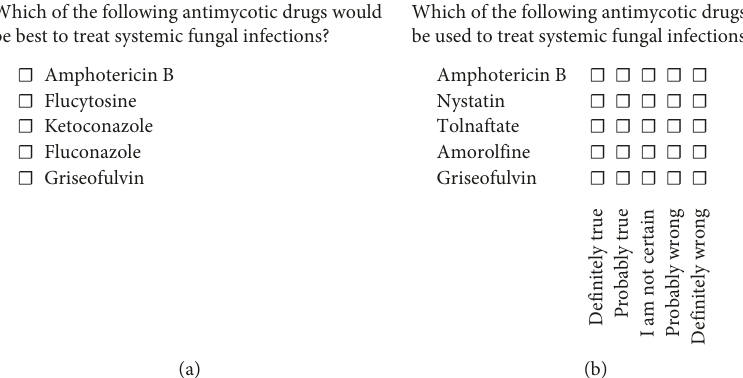
Figure 2: Examples of SC and R5 question types. Sample questions with their five alternatives and the corresponding key used in 2012. (a) Left panel: the question as it was used in prior exams in the SC format requiring to check the one and only true alternative and to leave false alternatives blank. (b) Right panel: the same question with slightly modified stem to allow for multiple true alternatives. Students were asked to rate each alternative on a 5-point scale